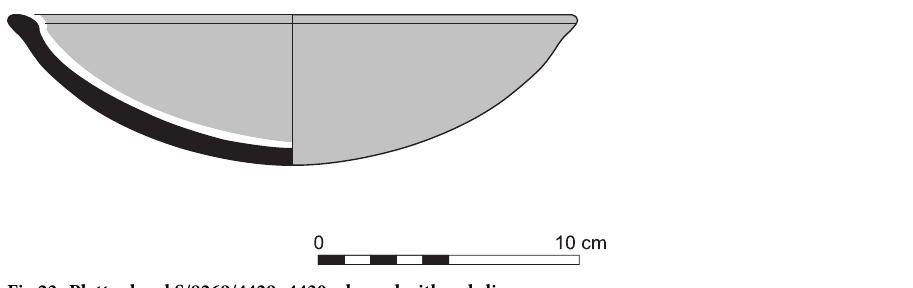
Fig 23. Platter bowl S/8269/4429+4430 adorned with red slip.